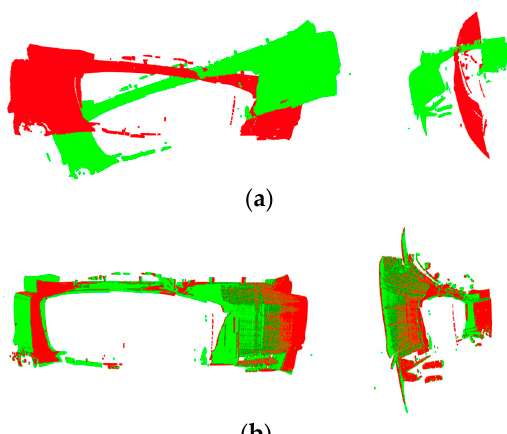
Figure 24. Effect of DeepMerge on point cloud stitching and registration with arbitrary error. ( a )